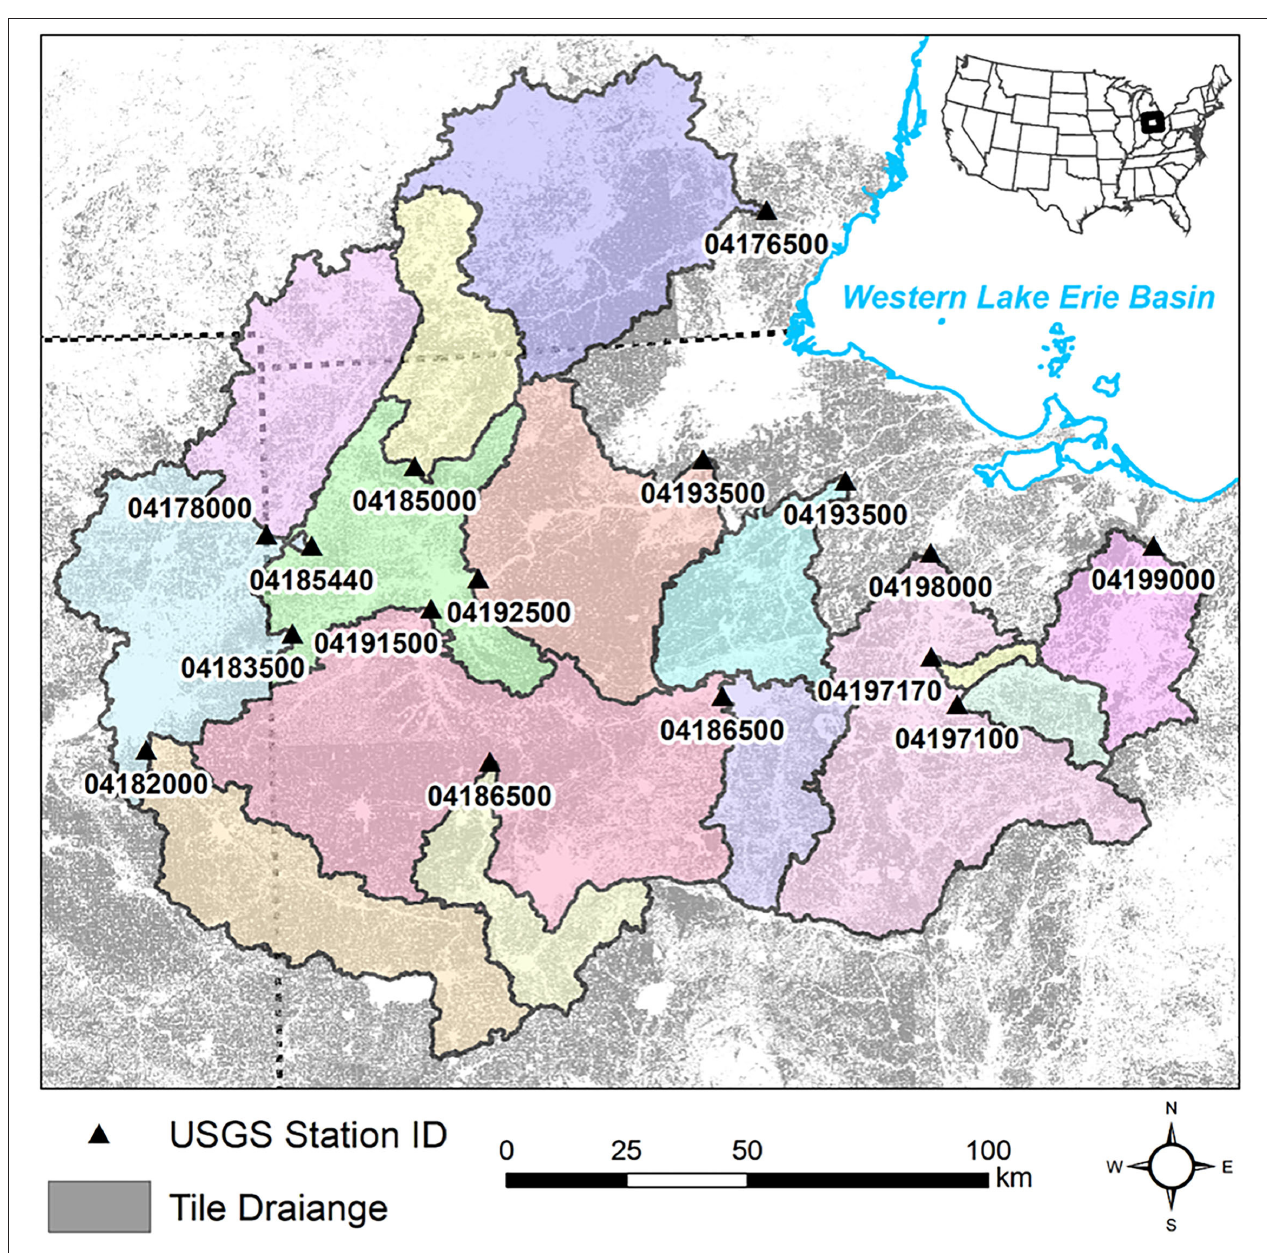
FIGURE 1 | Location of the 16 USGS gaging sites with their corresponding drainage areas. Tile drainage distribution shown in gray. The dotted line refers to state boundaries. The 16 watersheds are shaded in unique colors to distinguish their